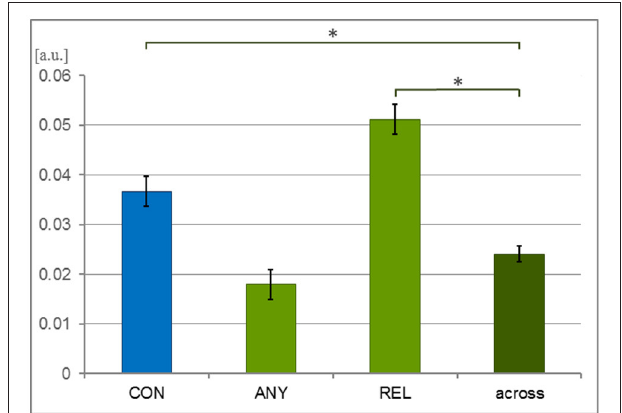
FIGURE 2 | Covariance of behavioral responses. Thirty-six participants watched 6 video clips of 2 narrations each during a behavioral experiment. The time series of button press responses were analyzed with covariance analysis. To compensate for the event frequency, the response profiles were resampled to the same number of button presses in each condition. These response profiles were expected to be more similar—and thus their covariance higher—for the same task than across different tasks. Indeed, the CON task (conventionality) and the REL task (relation to speech) yielded higher covariance than the across-task comparison but not the ANY task (any hand movement). Bars represent mean ± SEM; * p < 0.001; [a.u.], arbitrary unit.